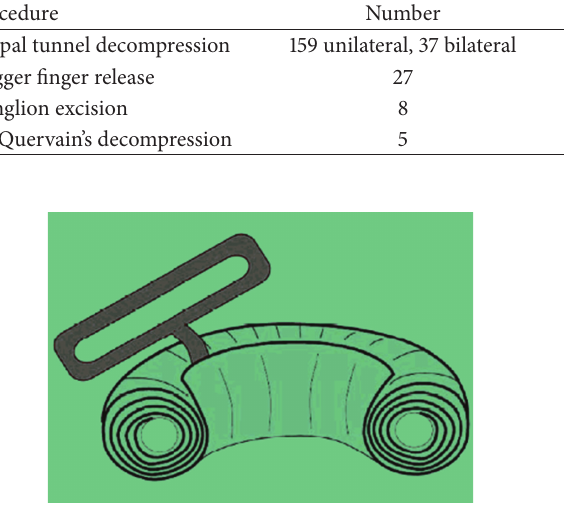
Figure 1: Cross section of the S-MART tourniquet.